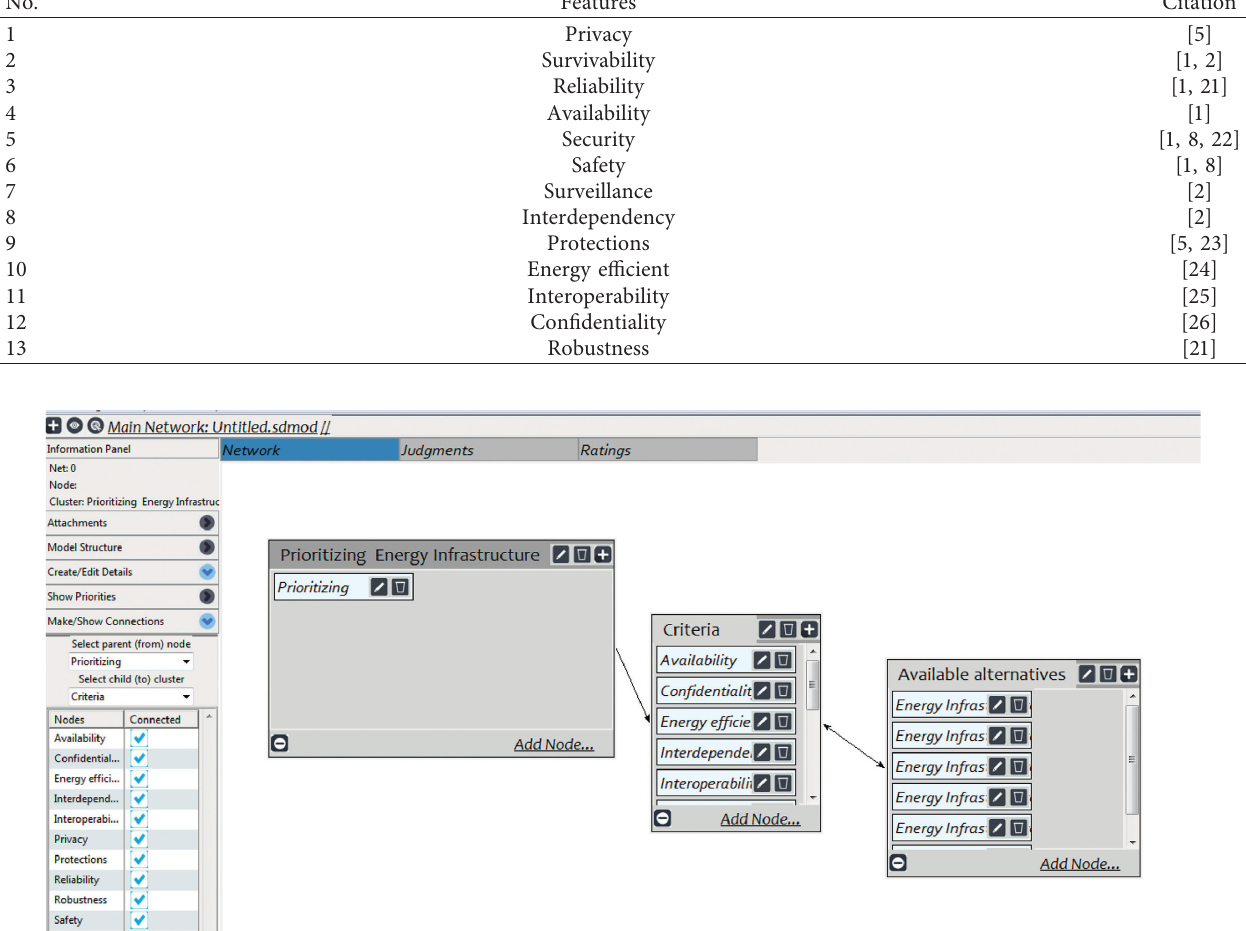
Figure 1: Hierarchy of the proposed experiment for critical energy infrastructure.